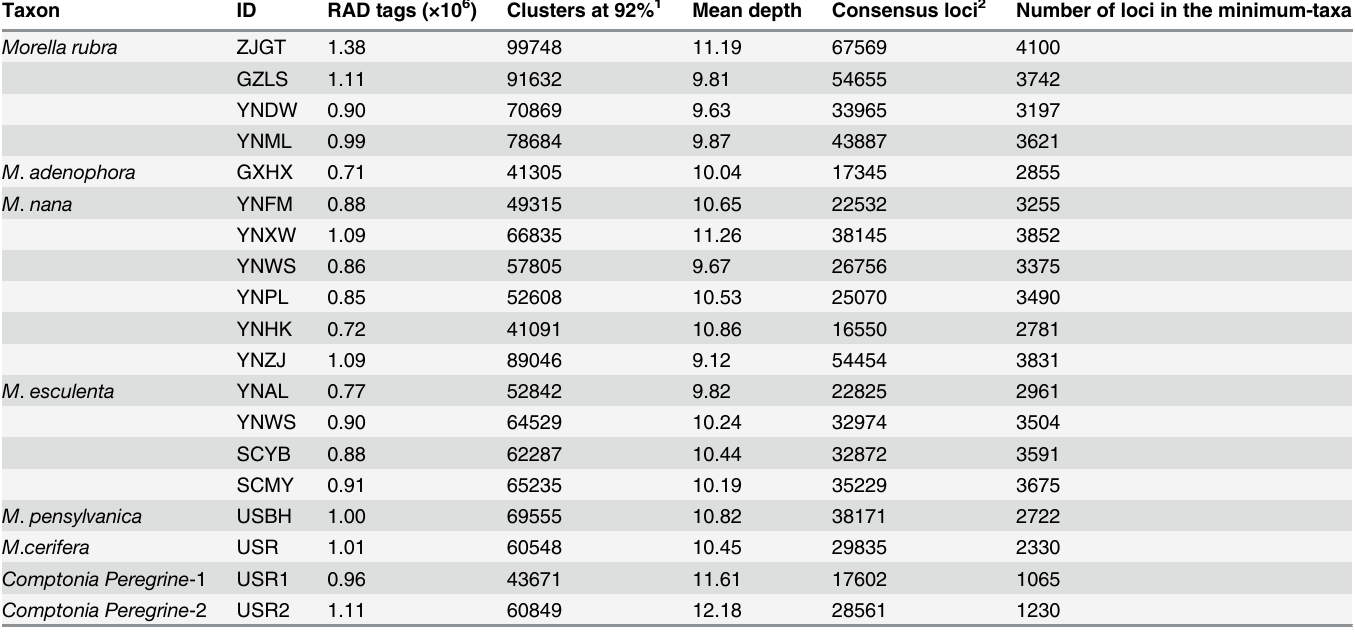
Table 3. Results of filtering and clustering of one single end RAD sequences (R1) from 19 samples in this study.